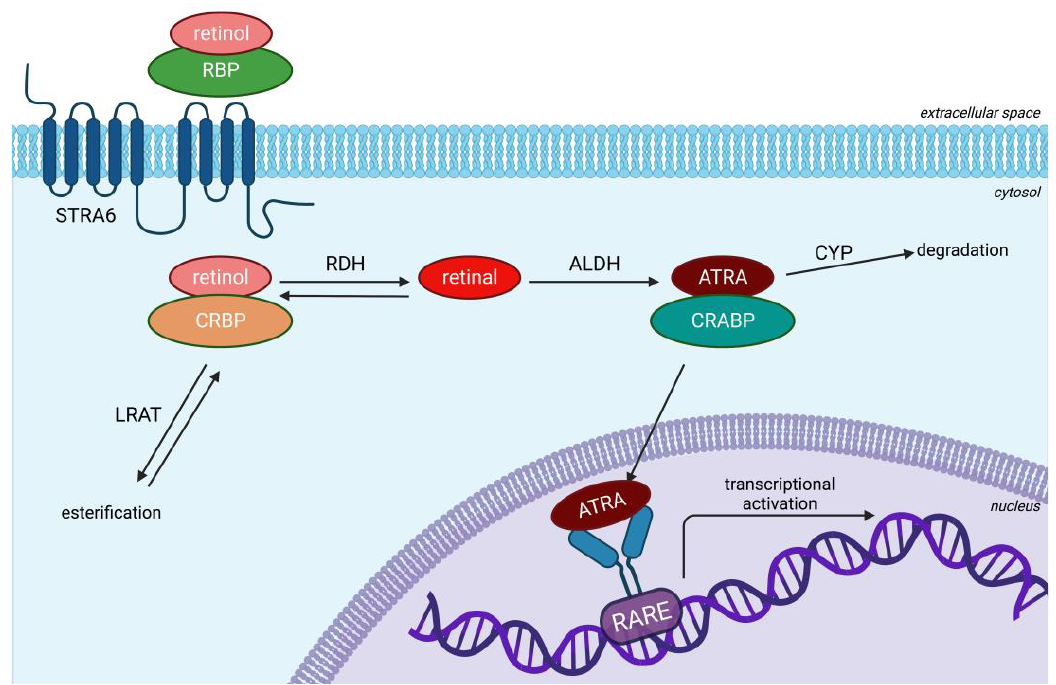
Figure 1. Overview of RA biosynthesis and the canonical pathway of transcriptional activation. Schematic provides a view of the cell membrane, with flanking extracellular space (white) and the cytosol (blue), the latter containing the nuclear compartment (purple). Retinol enters the cell via STRA6(l) proteins, and is bound by CRBP. Next, it can be reversibly esterified for storage by LRAT, or processed by two sequential oxidation reactions by RDH and ALDH enzymes to form ATRA. ATRA can be bound and enter the nucleus upon interactions with RAR/RXR nuclear receptors, or degraded via the action of CYP26 enzymes. Figure created with BioRender.com.